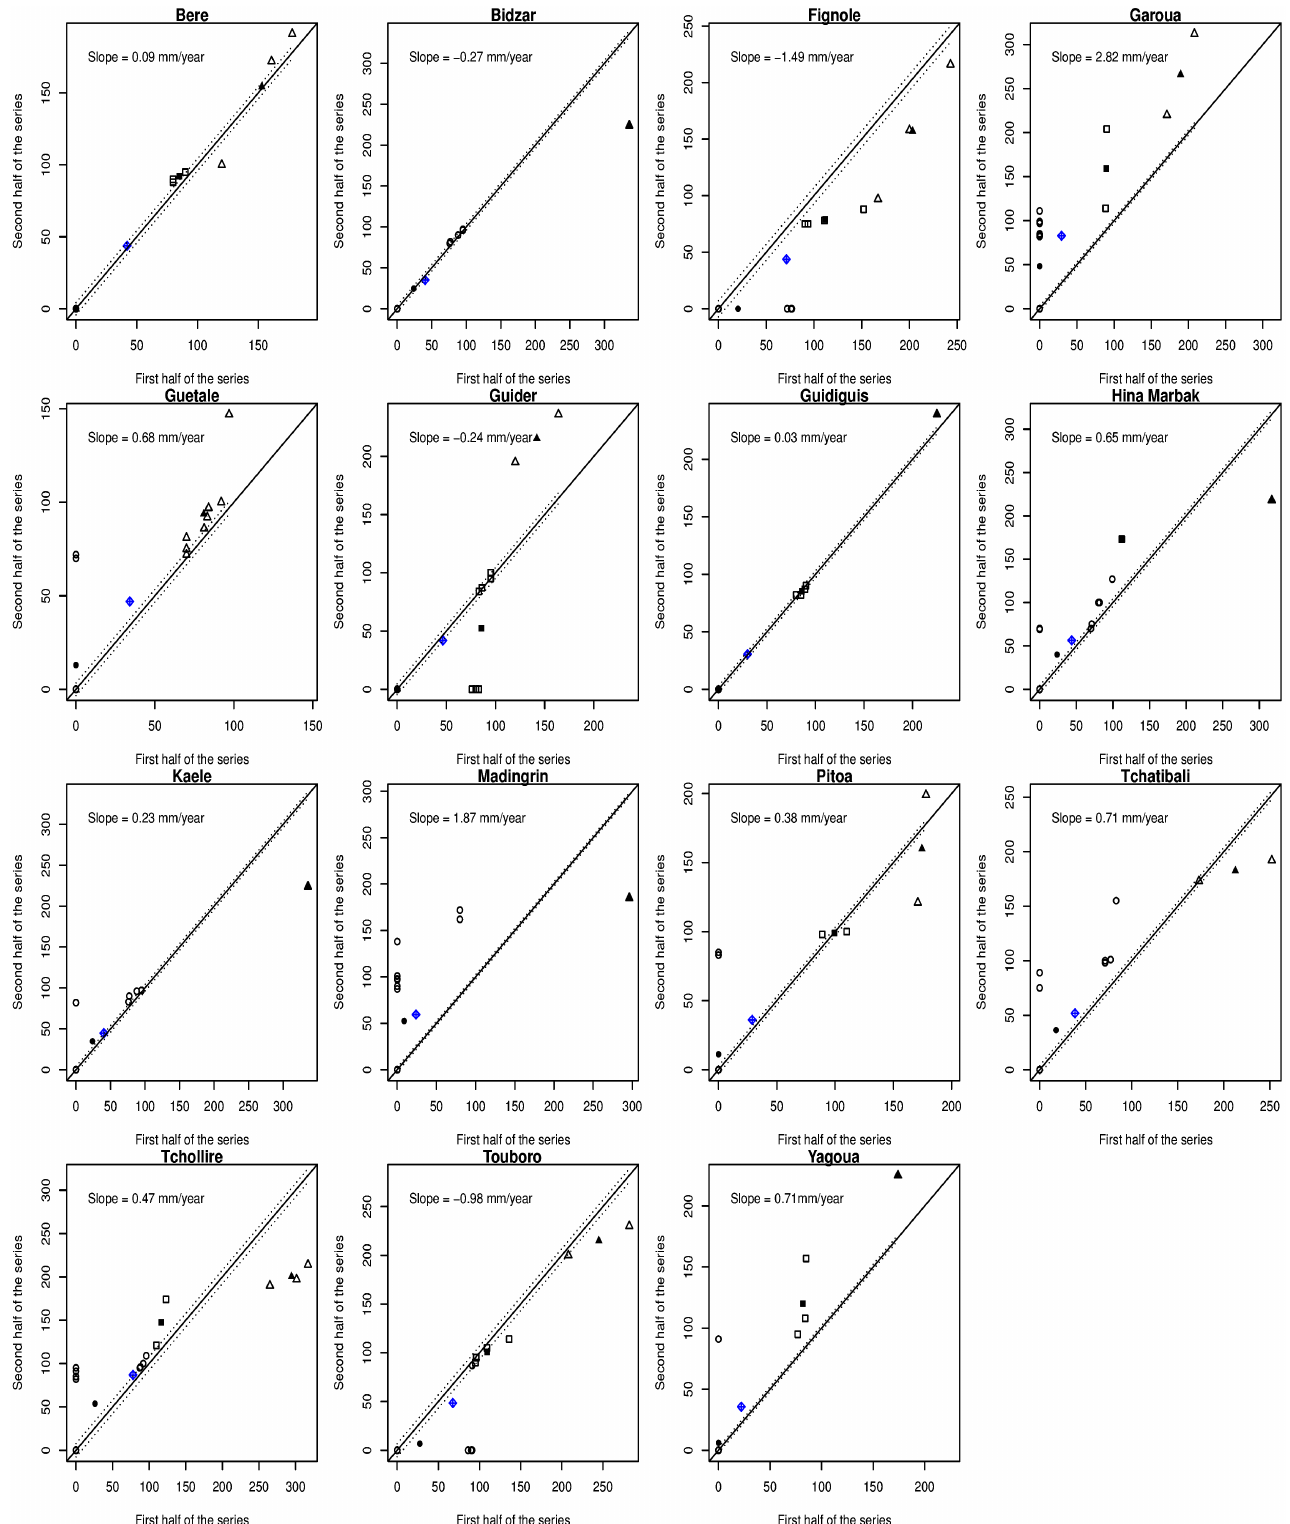
Figure 9. As in Figure 8, but for